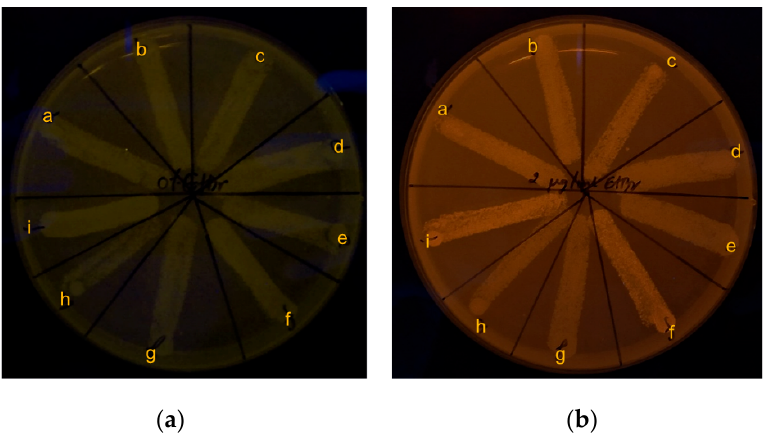
Figure 7. Phenotypic efflux pump activity of B. pseudomallei by EtBr-agar cartwheel assay: ( a ) 0% EtBr agar (control); ( b ) 2 µg/mL EtBr agar. Broth conditions for 30th generation passage: image overlay: a) B. pseudomallei 1026b in untreated control broth; b) broth supplemented with ¼ MIC of CAZ; c) broth supplemented with ¼ MIC of AgNPs. For H777: d) untreated control broth; e) broth supplemented with ¼ MIC of CAZ; f) and broth supplemented with ¼ MIC of AgNPs. For 316c: g) untreated control broth; h) broth supplemented with ¼ MIC of CAZ; i) and broth supplemented with ¼ MIC of